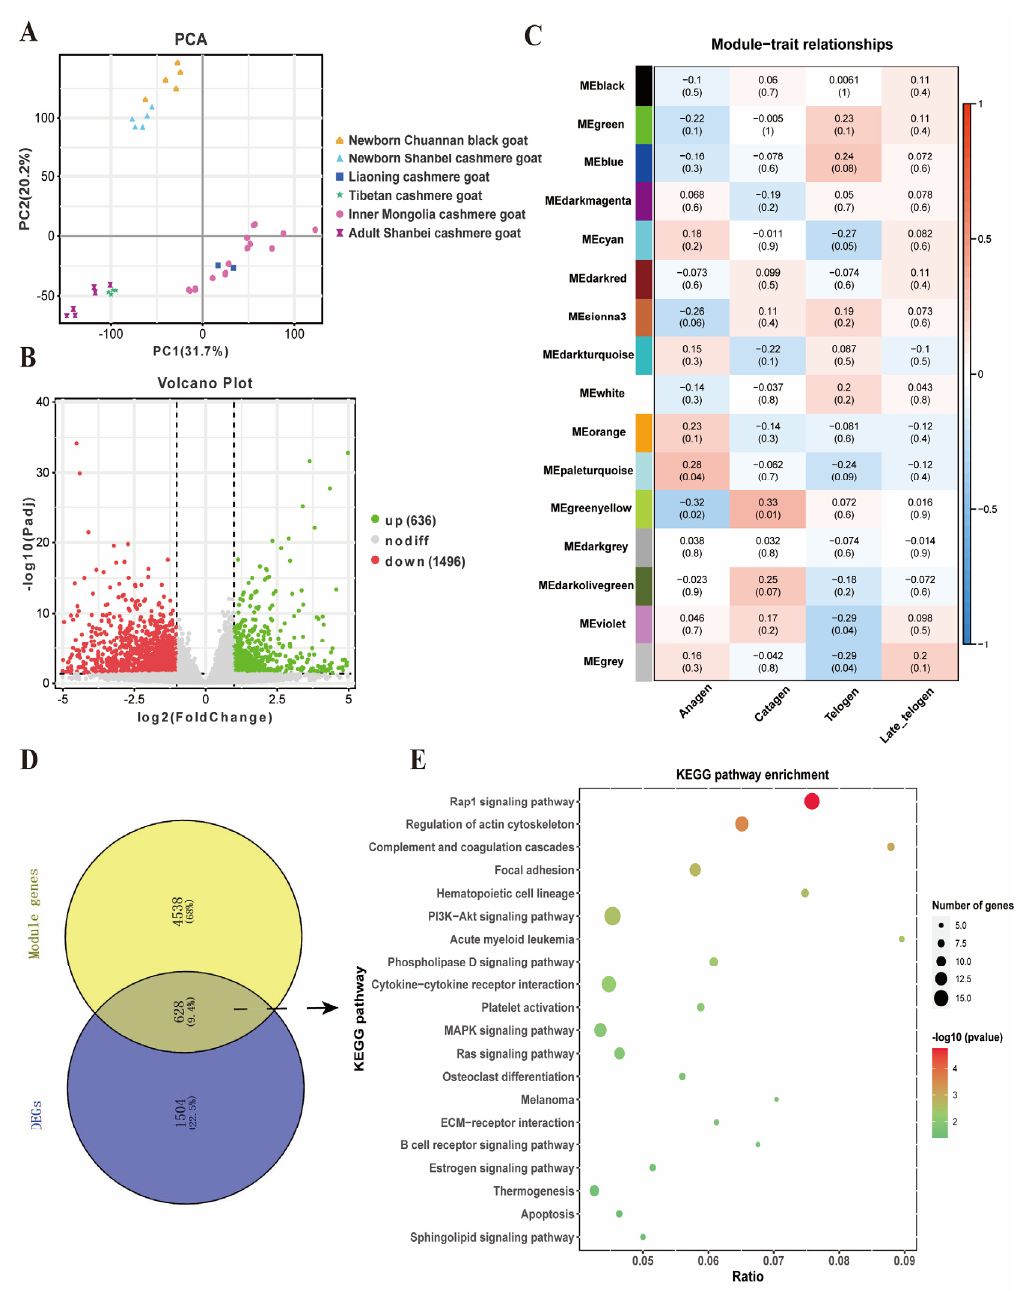
Figure 5. Co − expression analysis of skin transcriptome in cashmere goat. ( A ) The PCA analysis of all skin transcriptome samples of 58 goats from five breeds. ( B ) Volcano plot comparing the change in gene expression of the Chuannan black goats and Shanbei cashmere goats. The green and red dots represent the up-regulated and down-regulated genes, respectively. The gray dots represent genes that are not significantly different in the two breeds (FDR > 0.05). ( C ) Heatmap of the correlation between gene modules and hair follicle cycle features. ( D ) The overlap of differentially expressed genes (DEGs) and two module genes that are closely related to the hair follicle development in anagen. ( E ) KEGG pathway enrichment analysis of 628 shared expression genes.